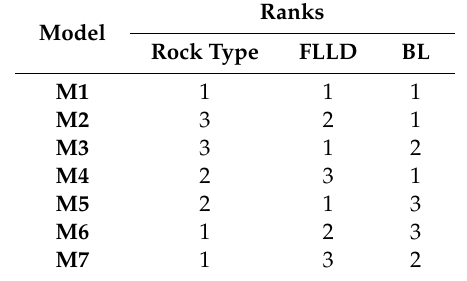
Table 1. Examined model parameters for causes probability. Model